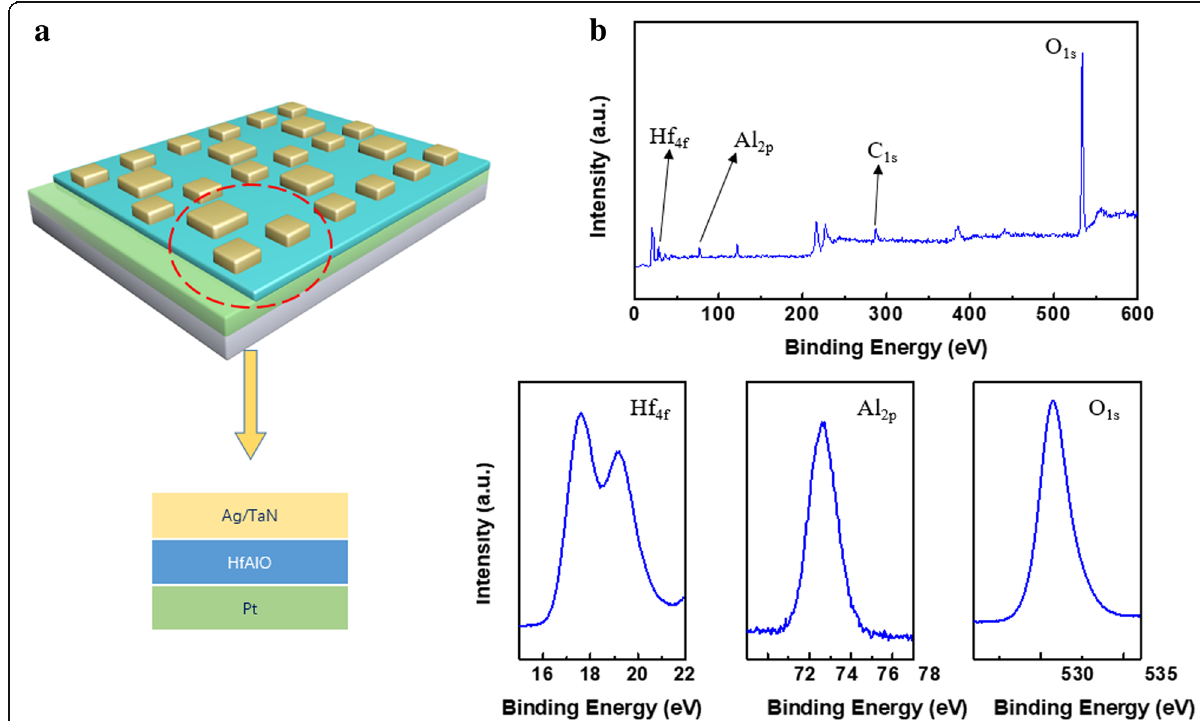
Fig. 1 a The schematic of Ag/HfAlOx/Pt and TaN/HfAlOx/Pt devices. b XPS spectra of the 16-nm